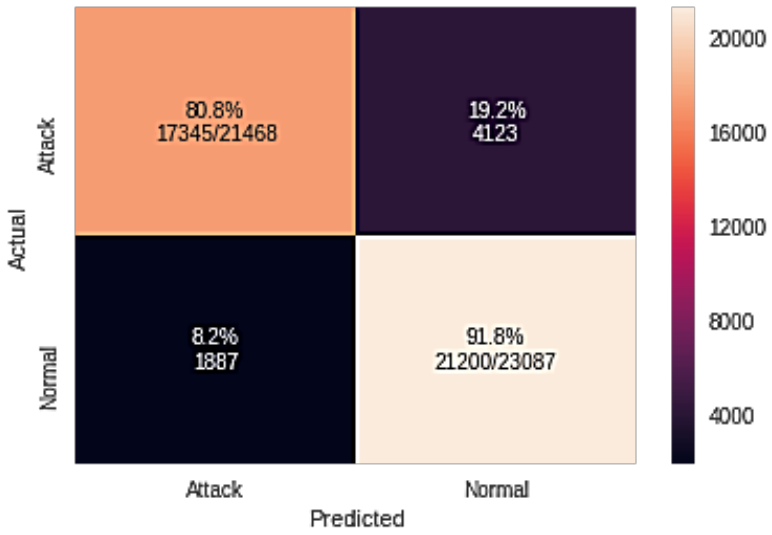
Figure 21. Naive Bayes binary class confusion matrix. Figure 22 represents the normal class with 83.7% precision, 91.8% recall and an 87.6% F1-measure. Precision for the attack class was 90.2%, recall 80.8% and F1-measure 85.2%, respectively.